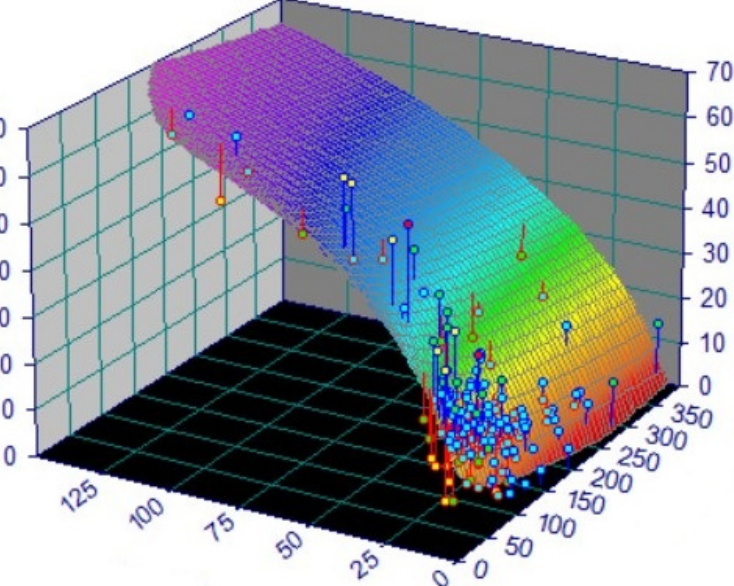
Figure 18. When the gas–liquid ratio is substituted into the calculation formula, the correlation between the calculated value and the experimental value is as shown ( xyz axis represents v sg , gas– liquid ratio and pressure drop (kPa), respectively).